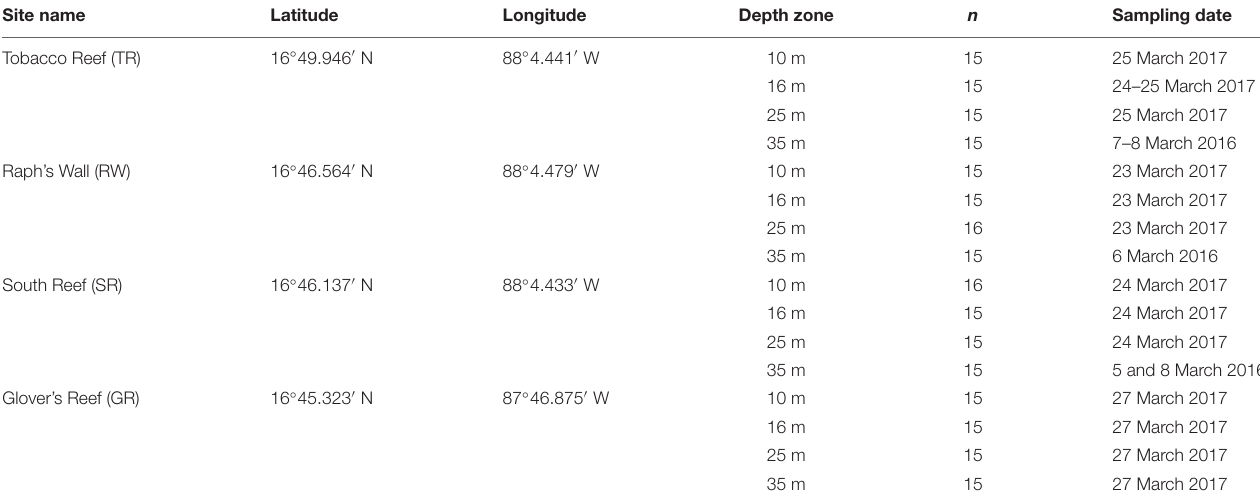
TABLE 1 | Site and sampling information for Montastraea cavernosa samples collected near Carrie Bow Cay, Belize. Site